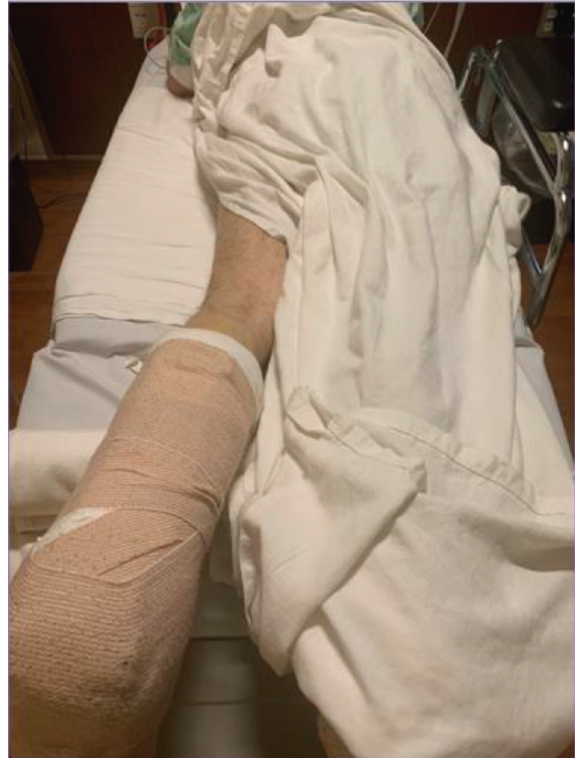
Figure 3: The near-miss was prevented from becoming a wrong- sided block by correctly visualizing the procedural mark on the right (i.e., correct) limb as part of the pause point before the second block (Case